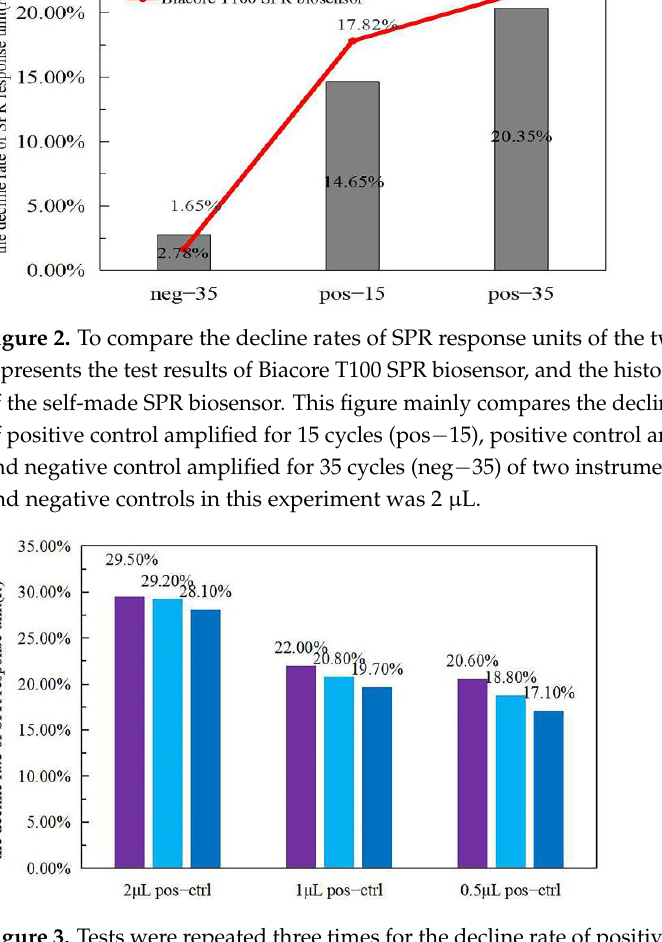
Figure 3. Tests were repeated three times for the decline rate of positive control (pos − ctrl) at different concentrations. It is clear that solutions with low concentrations of positive control have a small decline rate.